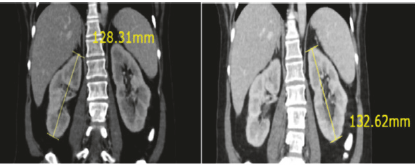
Figure 2: The change in size of the kidneys bilaterally after